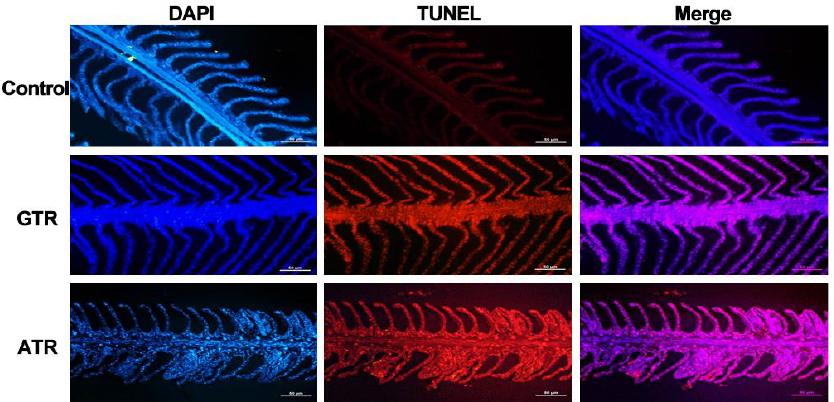
Figure 3. Programmed cell death evaluated by TUNEL (terminal deoxynucleotidyl transferase deoxy-UTP nick end l abeling) and DAPI (4′,6 -diamidino-2-phenylindole) after heat stress. C, Control; GTR, Gradual Temperature Rise; ATR, Abrupt Temperature Rise.